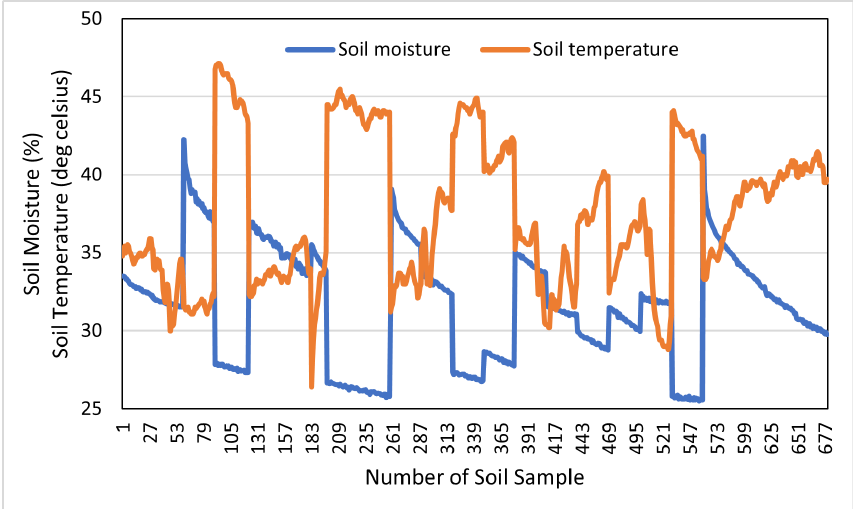
Figure 1. Soil moisture vs. soil temperature